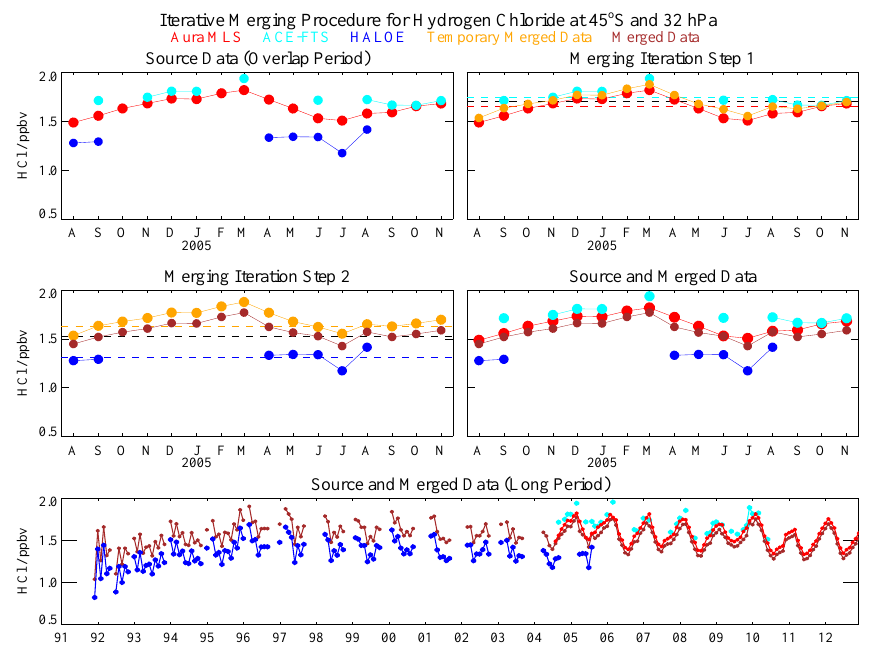
Figure 1. Merging procedure illustration for HCl. Top left panel shows the HCl monthly mean source data during the overlap period (Au- gust 2004–November 2005) for HALOE, ACE-FTS, and Aura MLS. Top right panel illustrates step 1 in the merging procedure, with the temporary merged data values (orange) resulting from the adjustment of ACE-FTS and Aura MLS values to the mean reference indicated by the black dashed line (time mean of co-located ACE-FTS/Aura MLS points). Also, the cyan dashed line is the mean of the ACE-FTS points and the red dashed line is the mean of MLS points co-located with ACE-FTS. Middle left panel shows step 2 results, namely the merged values arising from merging HALOE data with the temporary merged data; the black dashed line is the new average reference value, obtained from a 2 / 3 and 1 / 3 weighting of the dashed orange (mean of orange points co-located with HALOE) and dashed blue line (mean of HALOE) values, respectively. Middle right panel shows all the source data and the final merged values during the overlap period. Bottom panel shows the source and merged time series from 1991 through 2012 after the calculated additive offsets are applied to the whole source data sets, which are then merged (averaged) together wherever overlap between instruments